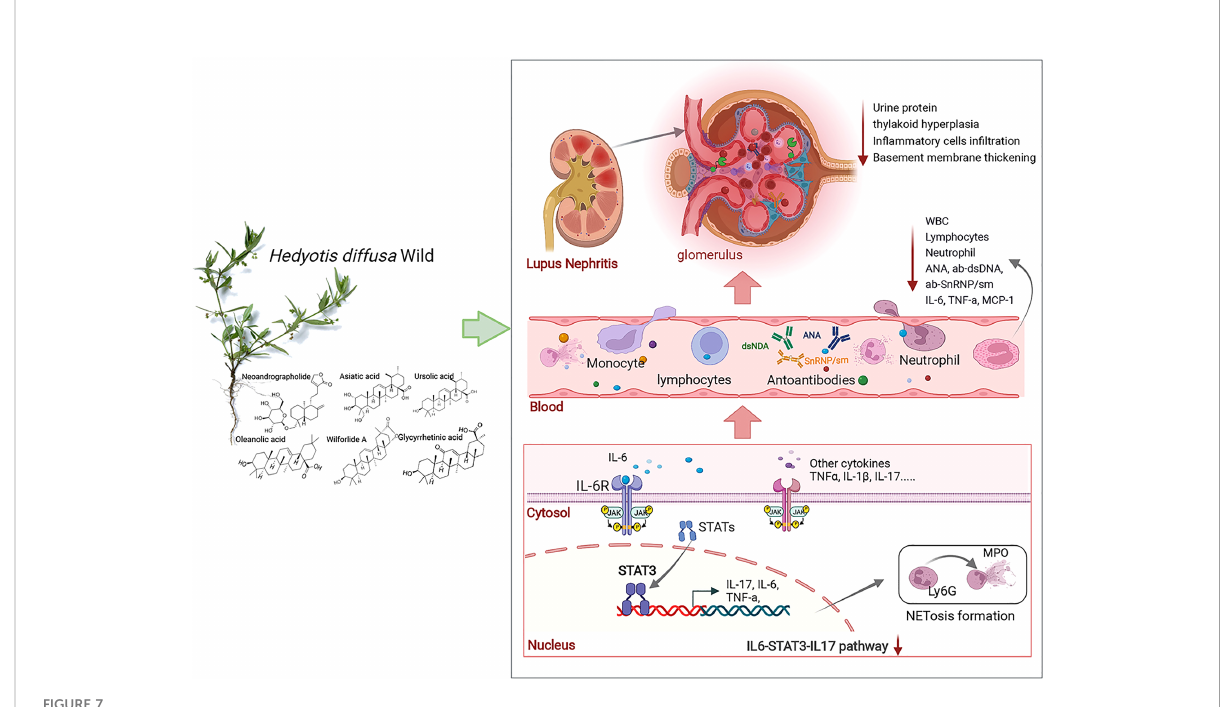
FIGURE 7 HDW exerts a protective effect against LN via STAT3/IL-17. IL-6, interleukin-6; MCP-1, macrophage chemoattractant protein-1; IL-17, interleukin-17; Ly6G, lymphocyte antigen 6complex, locus g; MPO,